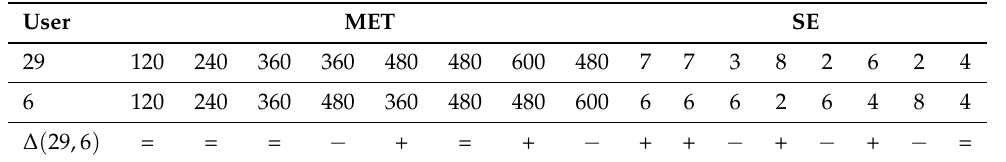
Table 1. Comparison between borderline profiles in